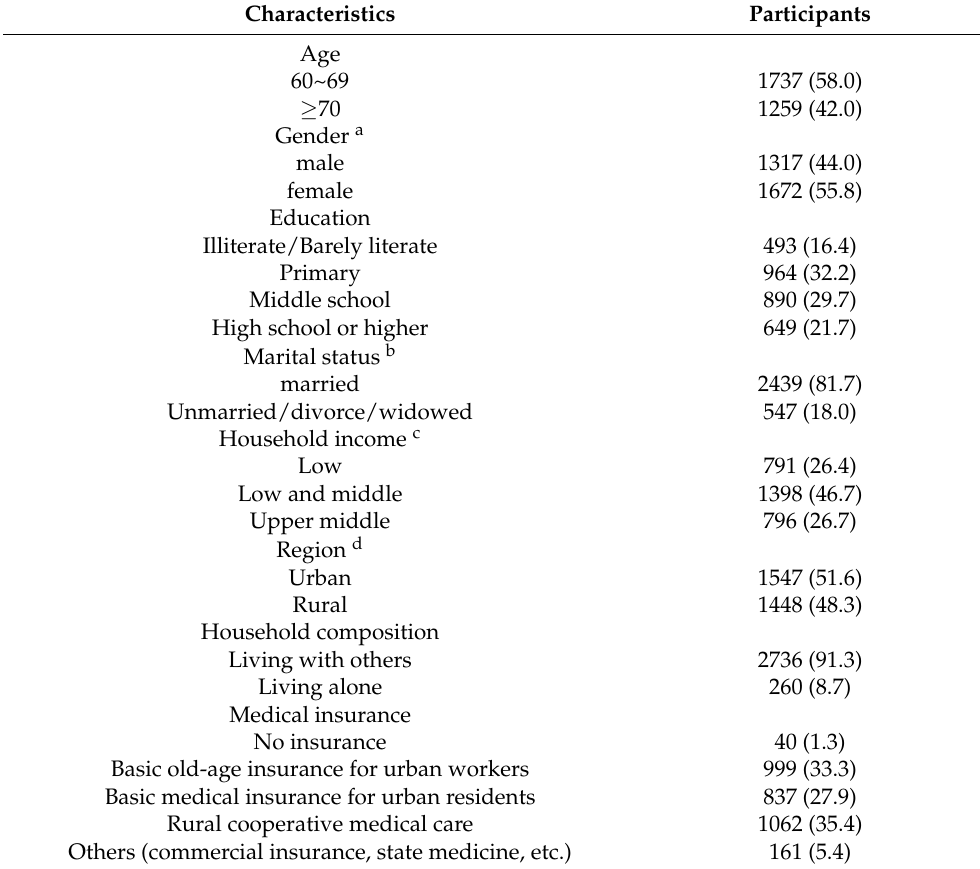
Table 1. The socio-demographic characteristics of the study participants.